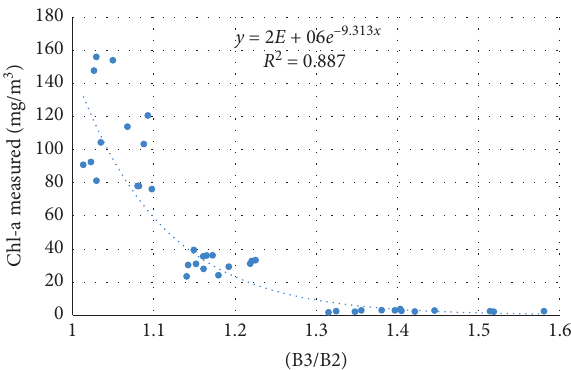
Figure 9: Regression between the Sentinel 2 band index and measured Chl-a, using the B3/B2